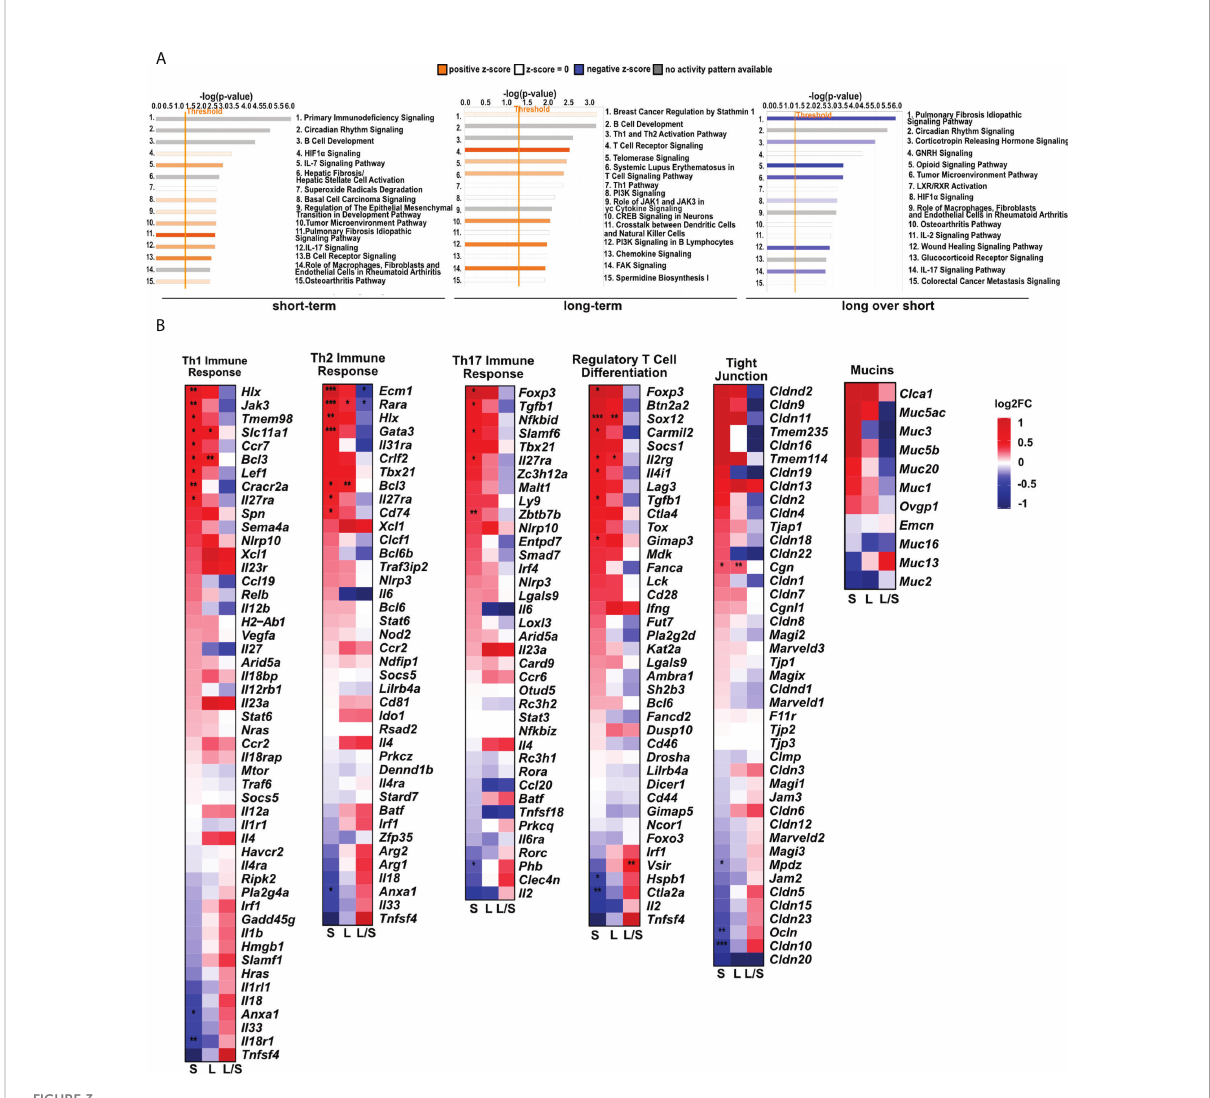
FIGURE 3 MSCs administration to nonin fl amed lungs causes changes in signaling pathways, and innate and adaptive immune gene clusters. (A) Changes in canonical and non-canonical signaling pathways after MSCs administration. A bar chart representing signaling pathways was generated using Ingenuity Pathway Analysis (IPA) Software. The top 15 most signi fi cant pathways in each group were presented. The gene cutoffs were adjusted on p-value<0.1, | Log2FoldChange|>0.5. Speci fi c tissue fi lters restricting the analysis to pathways related to lungs were applied. Bars marked as red indicate pathway upregulation, while blue bars indicate downregulation. Grey bars refer to no activity pattern was available. White bars correspond to the pathways with a z-score = 0. (B) Heatmaps represent genes related to Th1-, Th2-, and Th17- driven immune response, differentiation of T regulatory cells, tight junction molecules, and mucins. The ratios considering signi fi cantly regulated genes to the total number of genes were equaled as follows: 11/67 for Th1- (Biological Process; GO:0042088), 8/62 for Th-2 (Biological Process; GO:0042092), 6/59 for Th17- driven immune response (Biological